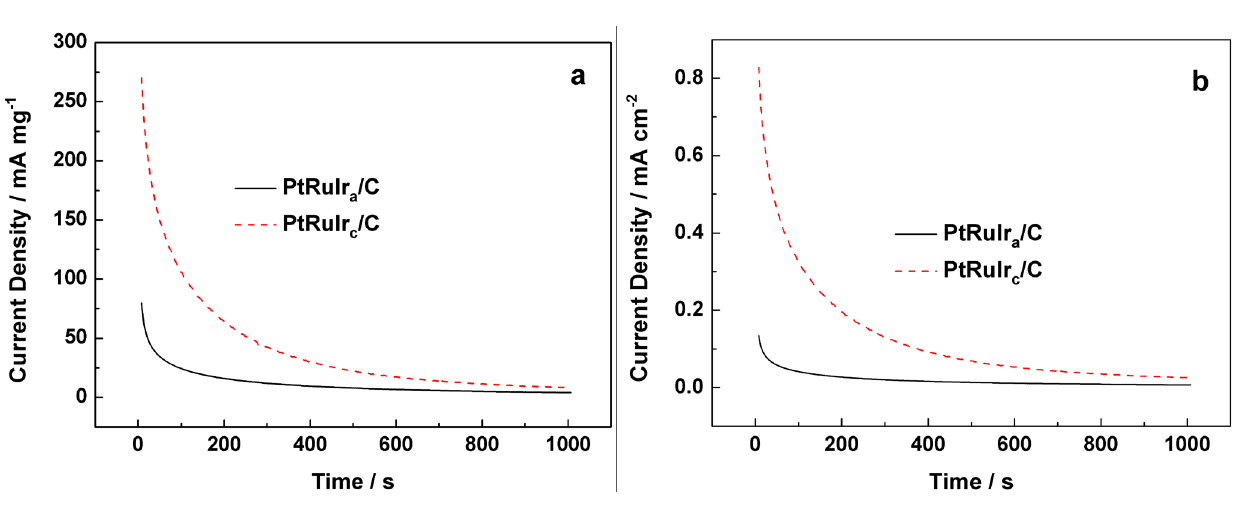
/C and PtRuIr /C catalysts for methanol a c